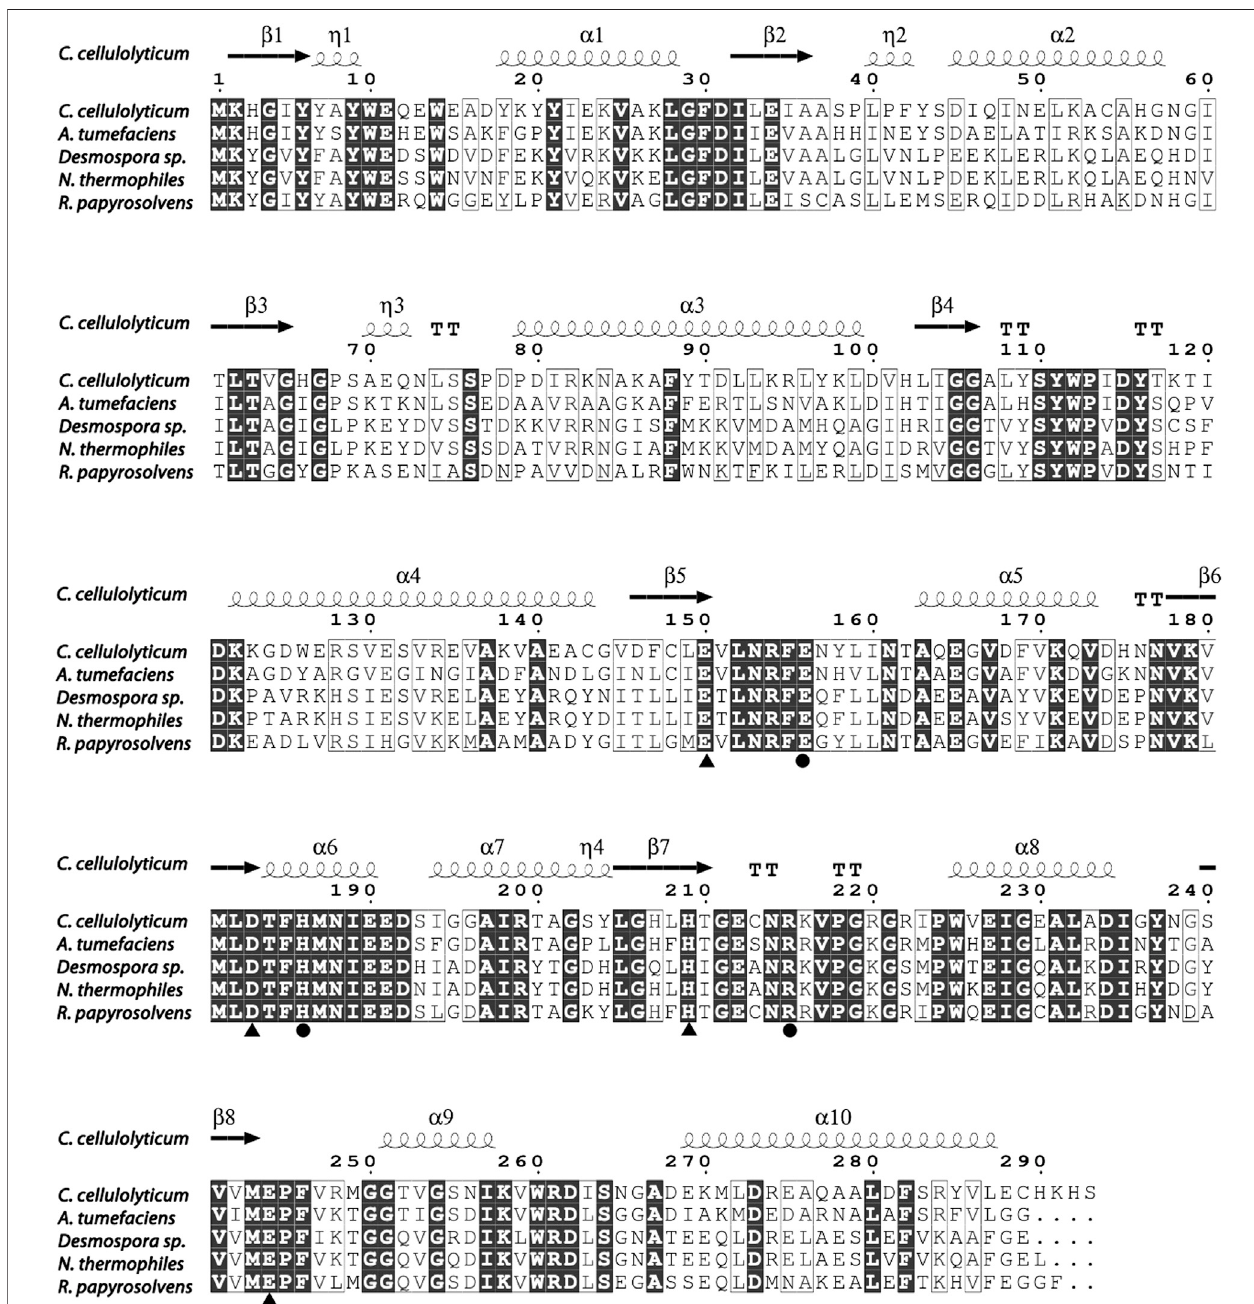
FIGURE 2 | Structure-based sequence alignment between R. papyrosolvens DAE and mentioned DAEs. The secondary structural elements of C. cellulolyticum (PDB:3VNI)arepresented.Identicalandsimilaraminoacidresiduesaremarkedinblackandframe,respectively.Trianglemarkasmetalionsbindingsite,andcirclemark as substrate (D-fructose) O-1, O-2, and O-3 binding sites.